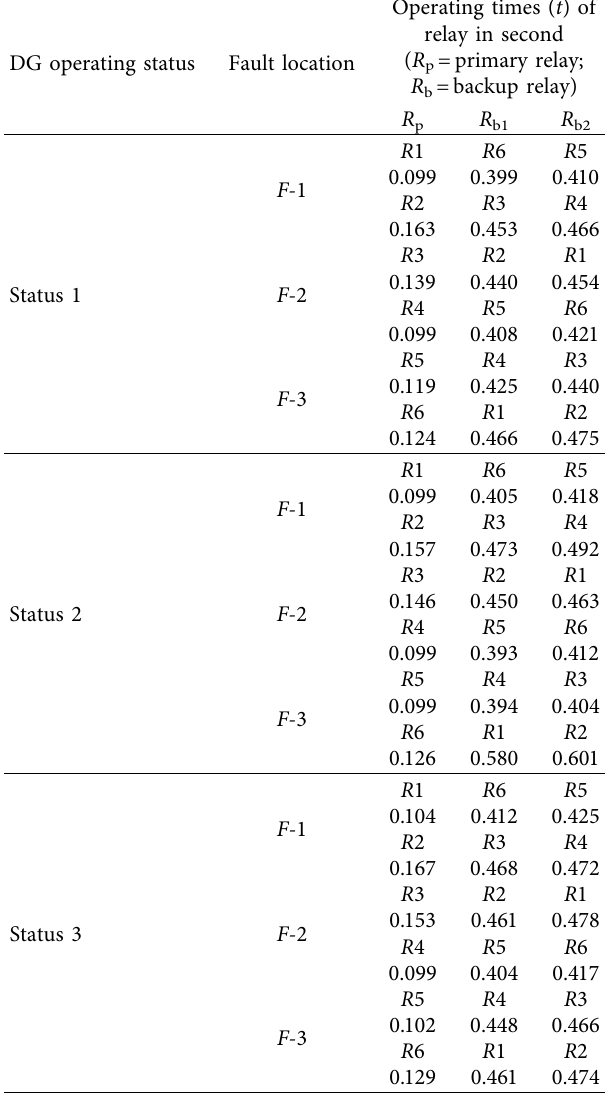
Table 11: Dual-directional primary and backup relay operating times for quaternary scheme in islanded microgrid.